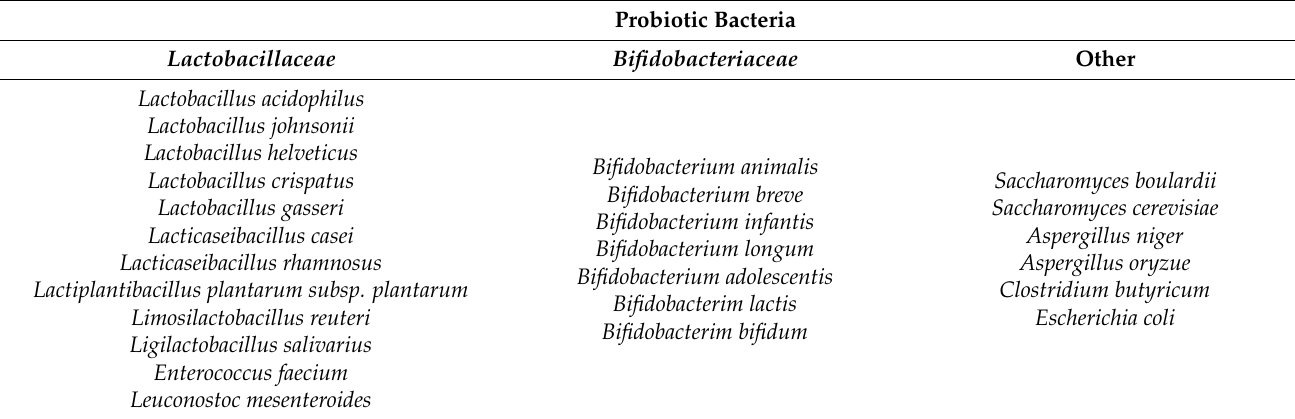
Table 1. The main probiotic strains.